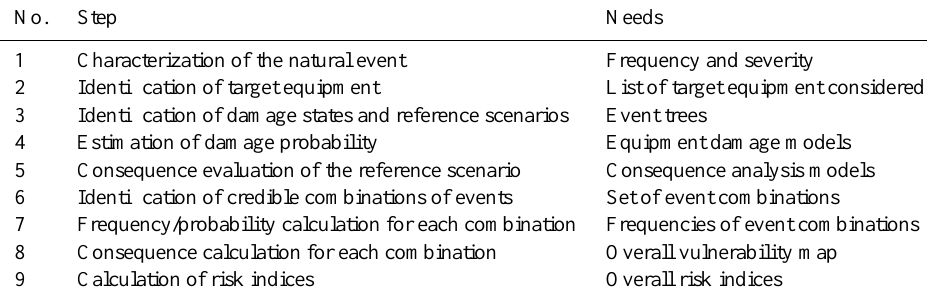
Table 2. Procedure used for the analysis of the risk induced by natural events in process plants. No.